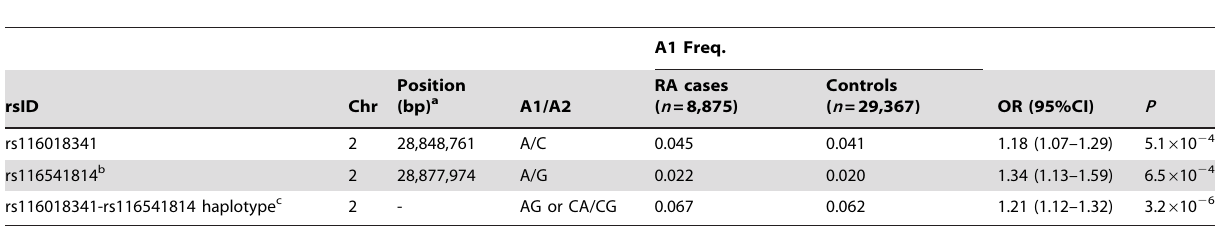
Table 2. Results of the GWAS meta-analysis of European RA case-control cohorts in the PLB1 locus.